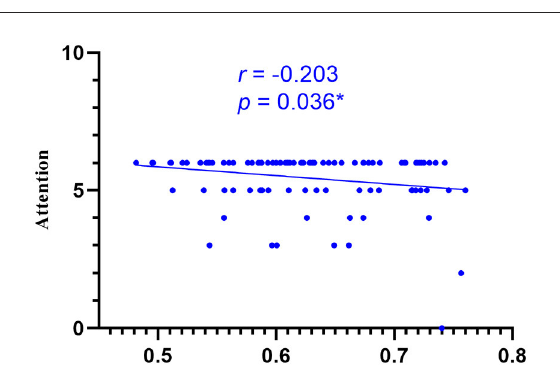
FIGURE9 Correlations of sGMV of cuneus gyrus and attention of MoCA in LAN patients. LAN, left acoustic neuroma; sGMV, smoothed gray matter volume. * p < 0.05.